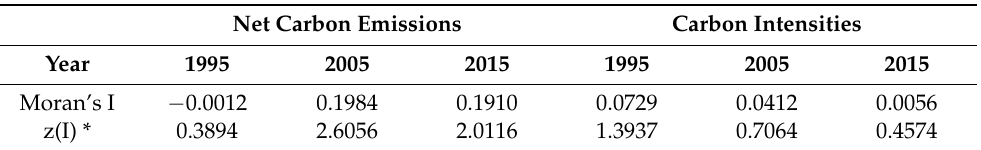
Table 6. The global Moran’s I and z(I) of carbon emissions and carbon intensities of the YRDUA in 1995, 2005, and 2015.